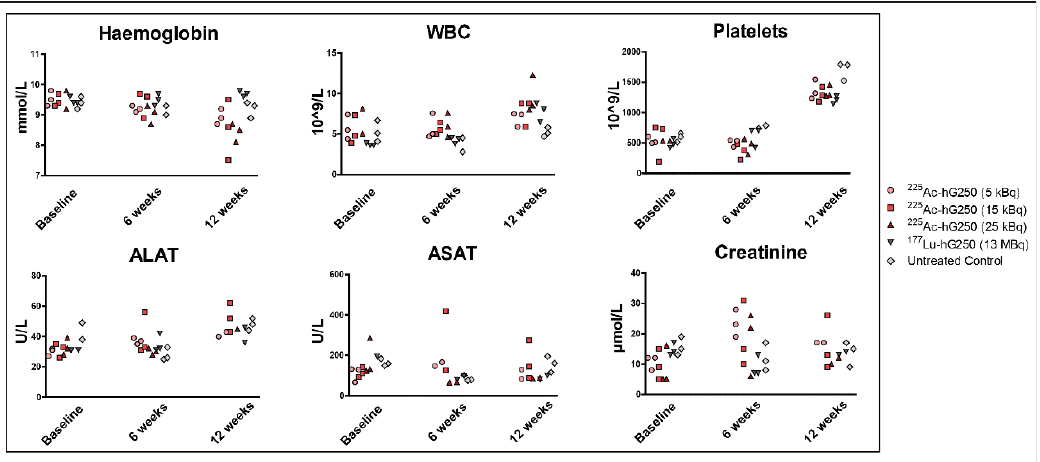
Figure 5. Hematological parameters in non-tumor-bearing mice at baseline, 6 weeks, and 12 weeks after treatment with 225 Ac-hG250 or 177 Lu-hG250.